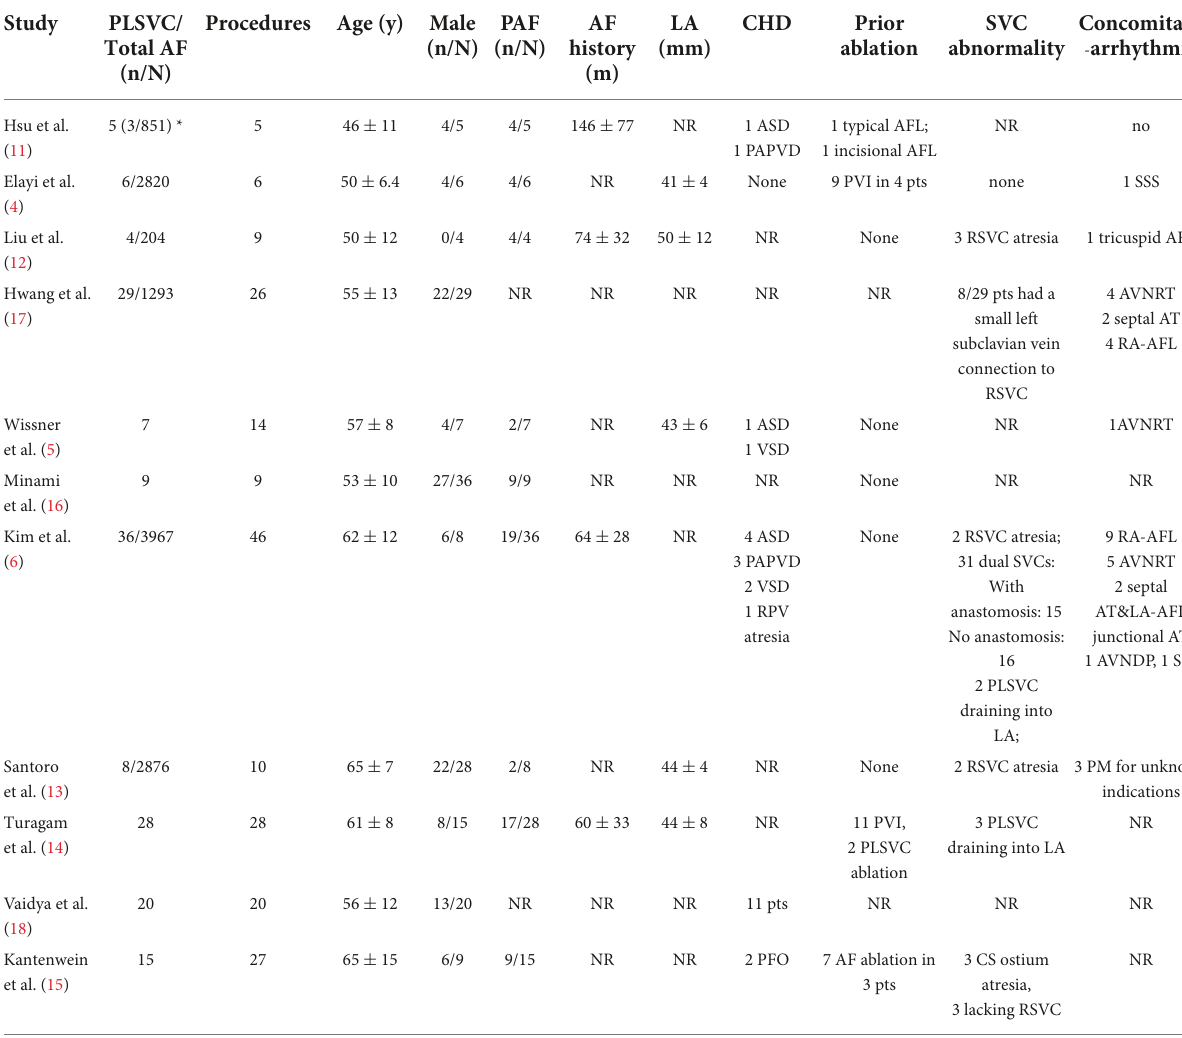
TABLE 2 Baseline characteristics of the enrolled